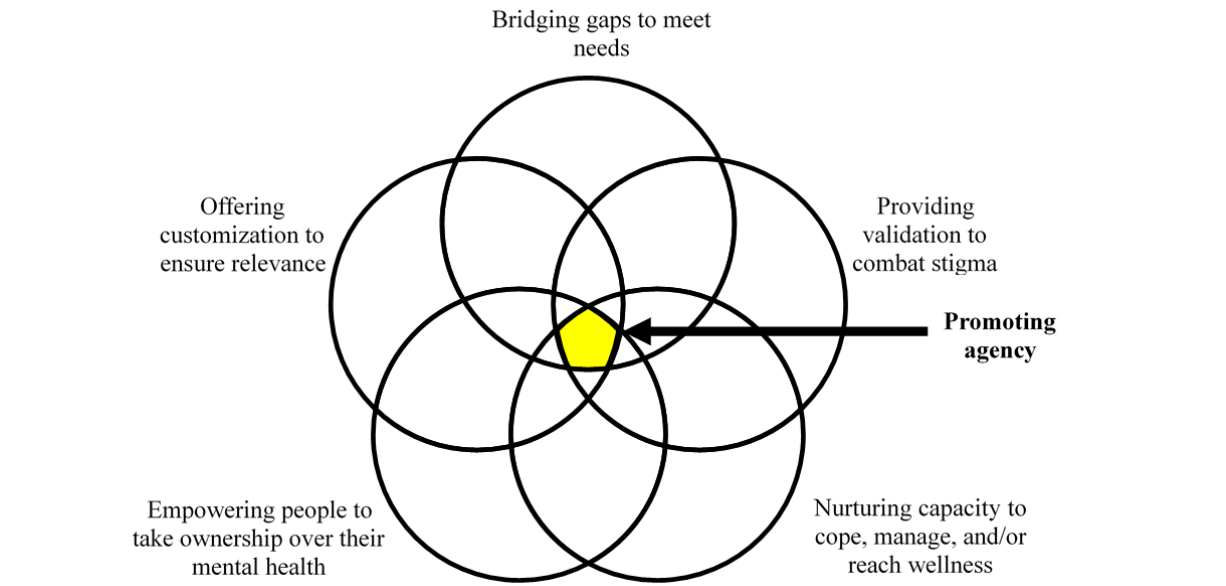
Figure 1. Intersection of the 5 themes leading to the overarching goal of promoting